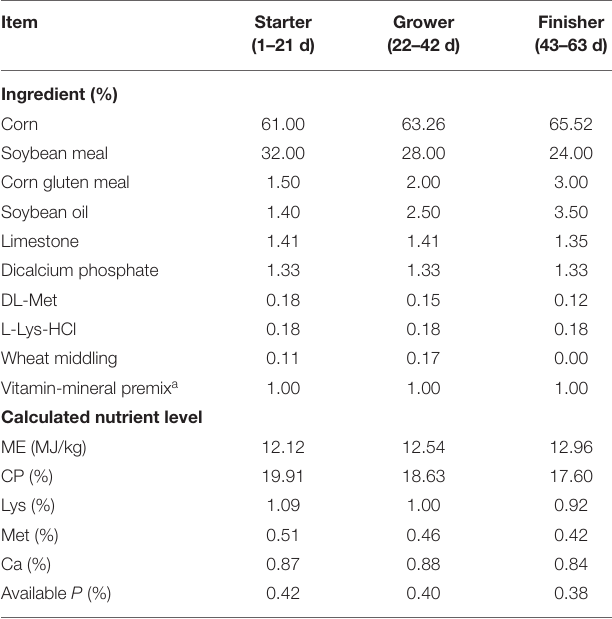
TABLE 1 | The ingredient and nutrient level of the basal